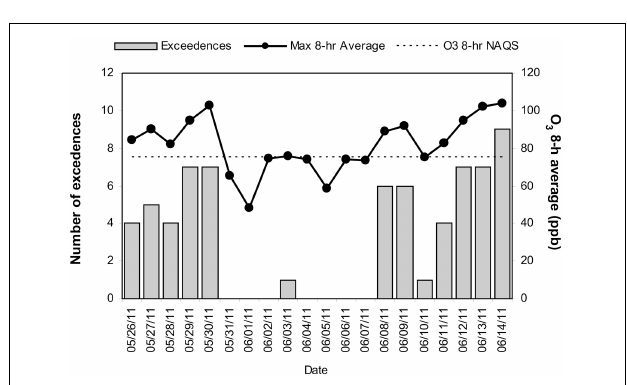
FIGURE 4 | Time series of 24-h average PM 10 in the MCMA children’s residency area from May 26 to June 14, 2011. The dashed line shows the US EPA NAAQS value for PM 10 24-h average concentration.